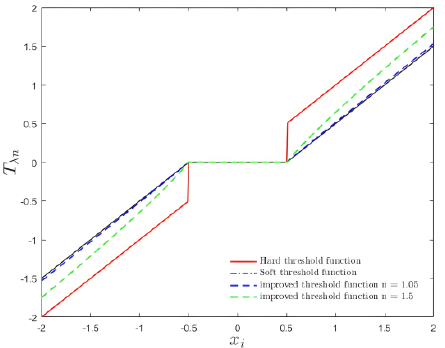
Figure 5. Threshold function diagram.